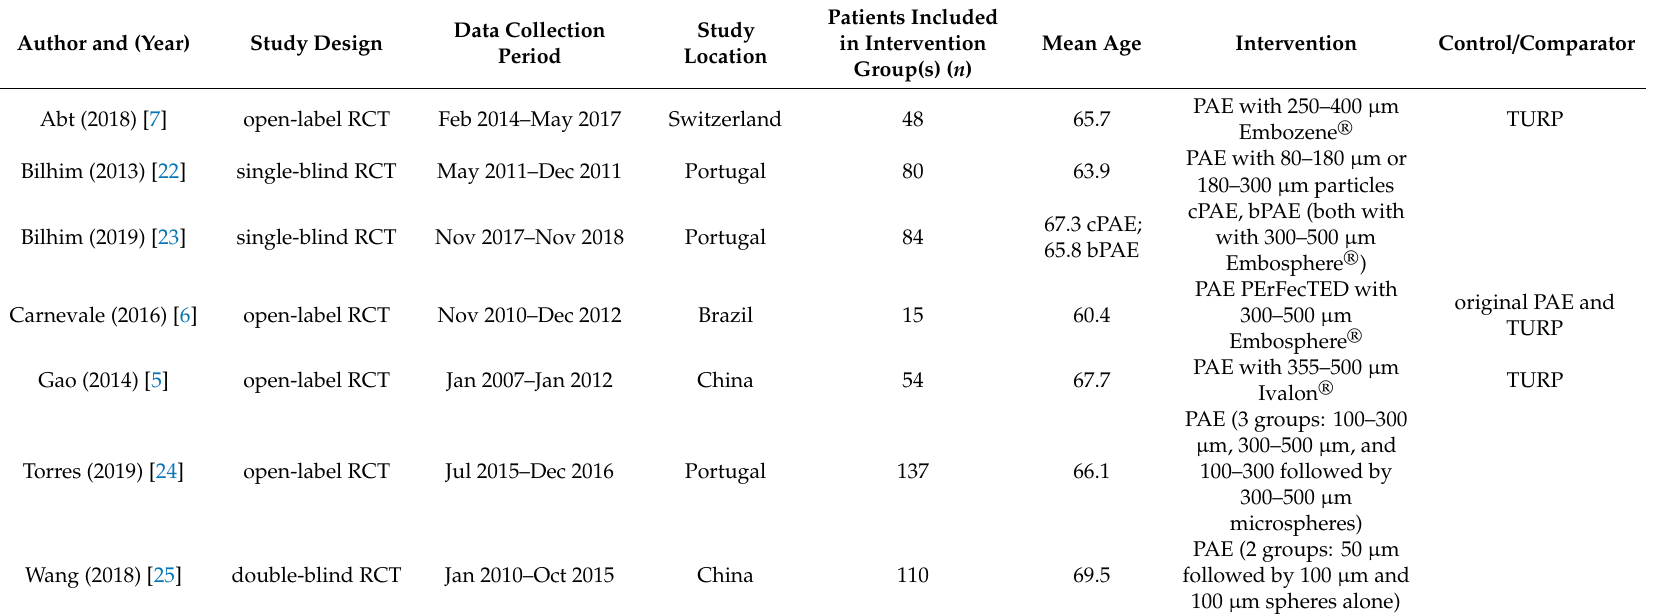
Table 1. Study characteristics of randomized trials